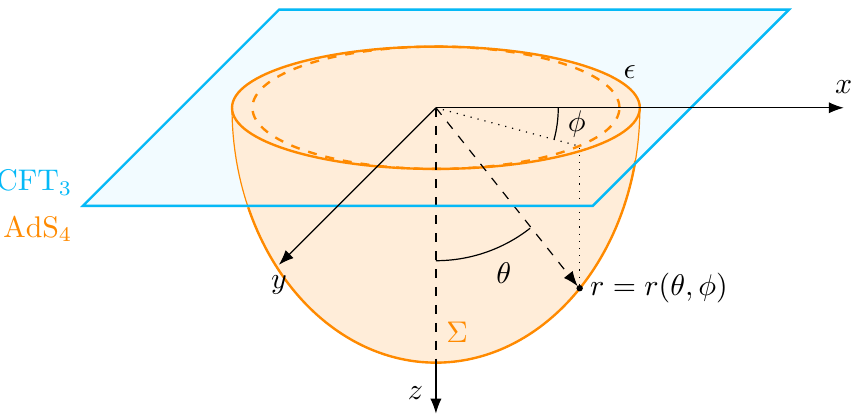
Figure 2 . Time slice of the extremal co-dimension two surface (cid:6) with an elliptical deformation (cid:15) ( ‘ =